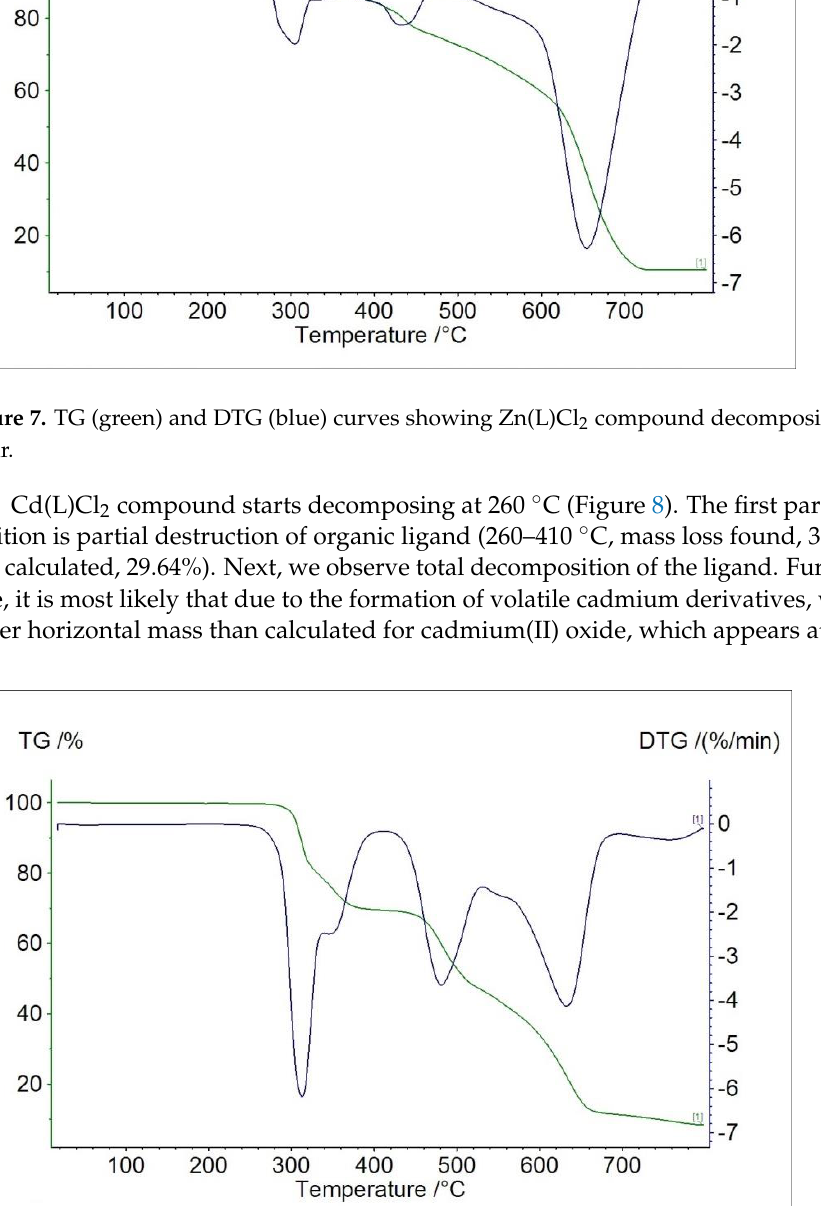
Figure 8. TG (green) and DTG (blue) curves showing Cd(L)Cl 2 compound decomposition pattern in air.